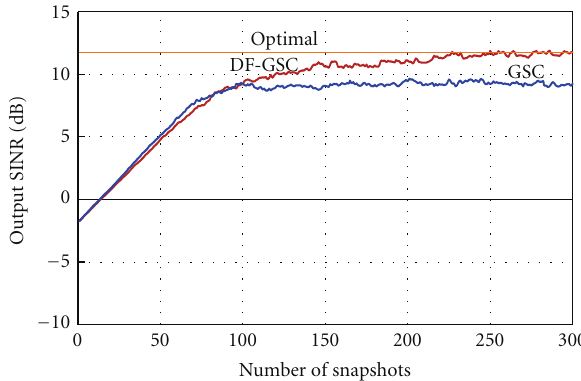
Figure 9: Learning curves for GSC and DF-GSC showing the com- parison of convergence rate. Compare Lee and Wu